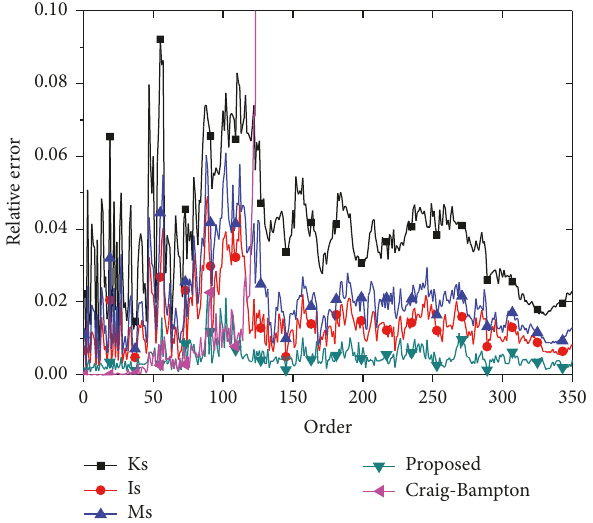
Figure 10: The relative error of mode frequency; 281 norm modes were kept for the dual assembly and 50 norm modes for the primary assembly.